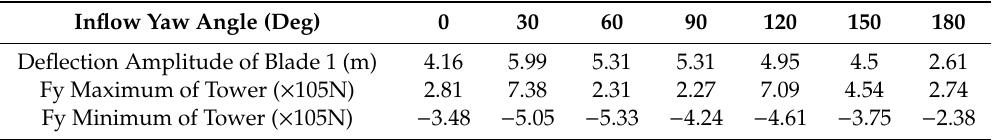
Table 3. Aeroelastic responses of 2 MW wind turbine at different yaw inflow angles of the typhoon. Inflow Yaw Angle (Deg) 0 Deflection Amplitude of Blade 1 (m)